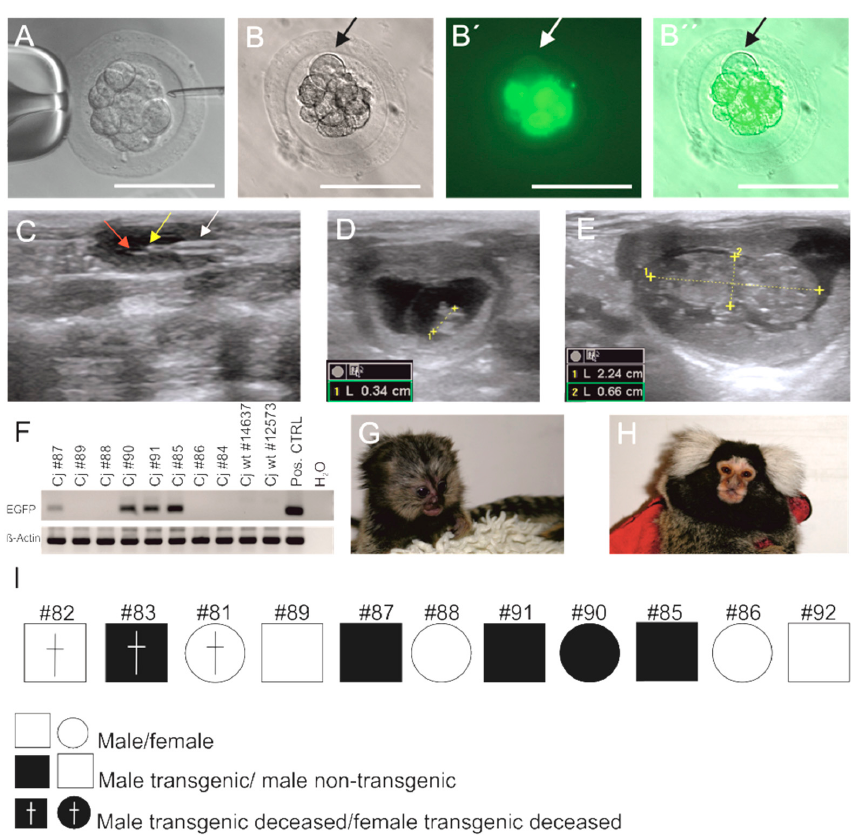
Figure 1. Generation of EGFP-transgenic marmoset monkeys. ( A ) Injection of the virus suspension into the perivitelline space of an 8–16 cell embryo. Scale bar: 100 µ m. ( B ) Bright-field image of an EGFP virus-injected embryo. ( B (cid:48) ) Fluorescent image of the embryo shown in ( B )), 4 h after virus injection. The arrows highlight a blastomere lacking green fluorescence. ( B (cid:48)(cid:48) ) Merged images of ( B ) and ( B (cid:48) ). ( C ) Ultrasonographic image of an embryo transfer (ET) into a surrogate mother. The transfer catheter (white arrow) is placed in the lumen of the uterus (red arrow; yellow arrow: embryo). ( D ) Ultrasonographic image of an embryo 49 days after ET and ( E ) of an embryo 85 days after ET. ( F ) PCR genotyping of monkeys obtained after virus injection and ET. Animals #87, #90, #91, and #85 were EGFP-positive. ( G ) A transgenic postnatal marmoset (#90). ( H ) A transgenic adult marmoset (#90). ( I ) Overview of the postnatal animals obtained from injected embryos. Table 1. Production rate of EGFP -transgenic marmosets.